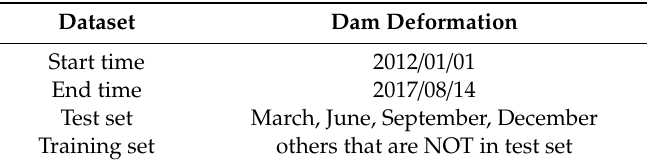
Table 2. Test dataset and ground truth